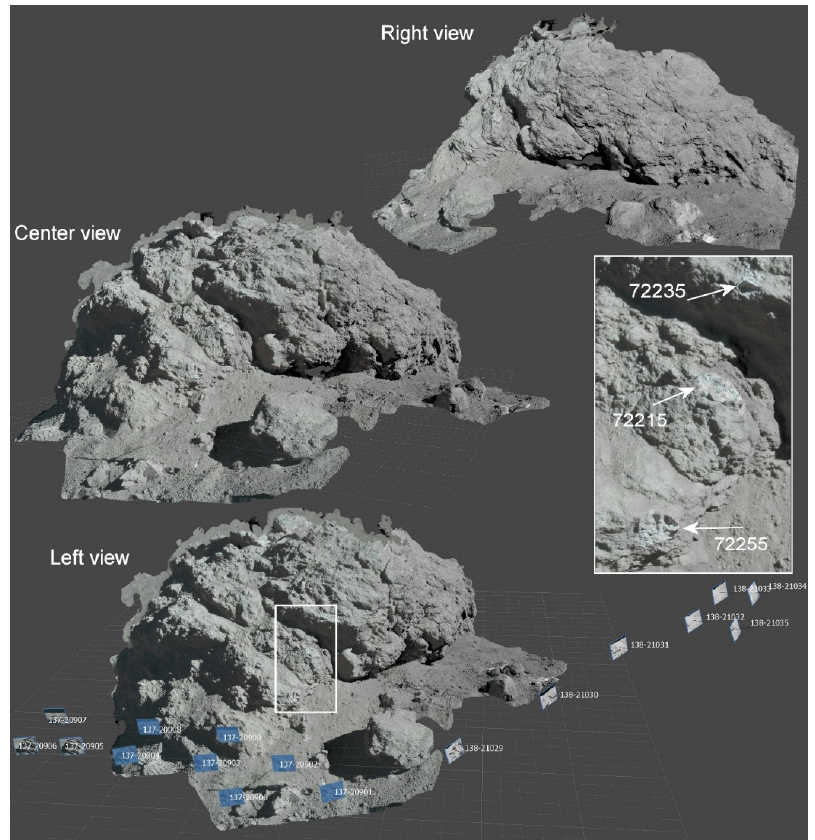
Figure 8. Photogrammetric reconstruction (textured 3-D model) of boulder 1 at Station 2. The location and orientation of the entry Apollo images labelled AS17-137-20900 to AS17-137-20909 and AS17-138-21029 to AS17-138-21042 computed by Metashape is indicated by annotated rectangles in the bottom perspective view. The inset (white rectangle) shows the quality of the textured 3-D model, with arrows pointing to the blue-gray markings left at the location of samples 72255, 72215, and 72235. The second place of interest at Station 2 is a ~3 ‐ m ‐ large boulder labeled “Boulder 2”, which rests on the Massif’s 14.9° slope (Figure 1). Figure 9 presents the 3 ‐ D reconstruction that we obtained using 19 images labeled AS17 ‐ 137 ‐ 20912 to AS17 ‐ 137 ‐ 20956. The alignment generated a sparse point cloud of about 136,000 tie ‐ points. The dense point cloud of 8 million points allowed the generation of a mesh of 500,000 polygons. The gnomon is present in several images, allowing its 3 ‐ D reconstruction together with the boulder. The boulder is similar in texture to the ones observed at intrusive melt ‐ breccias at Stations 6 and 7.